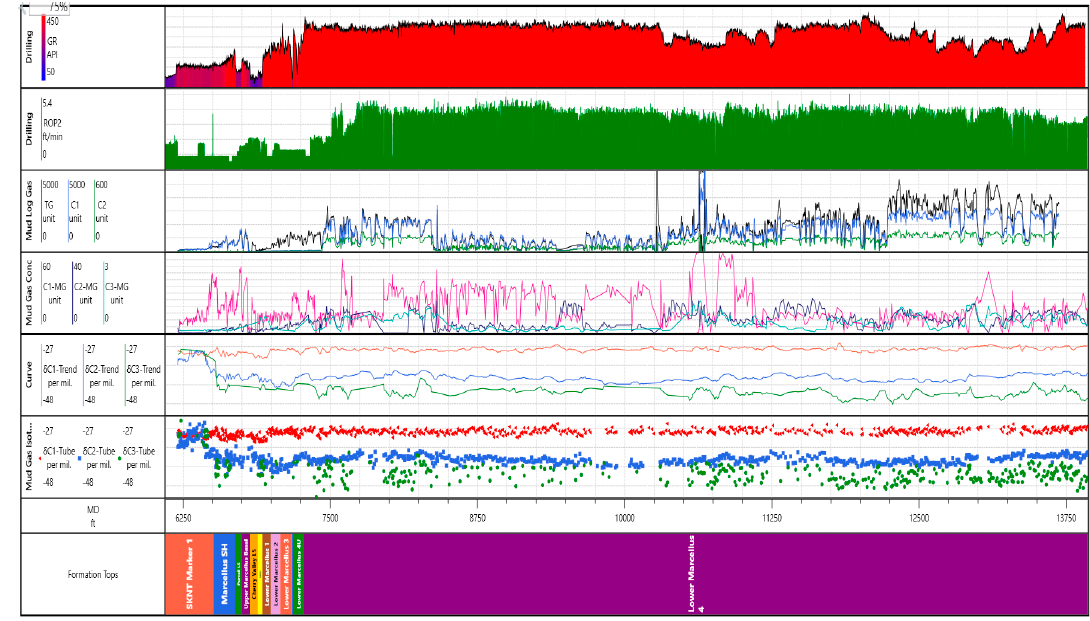
Figure 6. Mud gas isotope logging (MGIL) with the GC–IR 2 instrument in a lateral drilling process in the Marcellus Formation, northeast Pennsylvania. The top plot is the gamma signal, the second plot is drilling speed. The third plot is the mud gas reading from regular mud logging fast GC. The fourth plot shows gases loaded into the GC–IR 2 system. The fifth plot is a moving average of the MGIL plot. The sixth plot is the raw data of MGIL. The last line below x-axis (measured depth, MD) is the formation